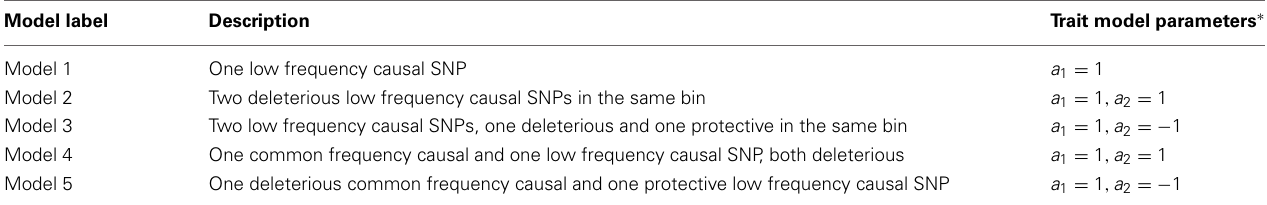
Table 2 | Five trait models for simulation of the quantitative trait data.